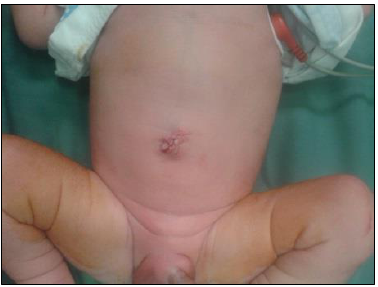
Figure 4: Umbilicoplasty after reduction of